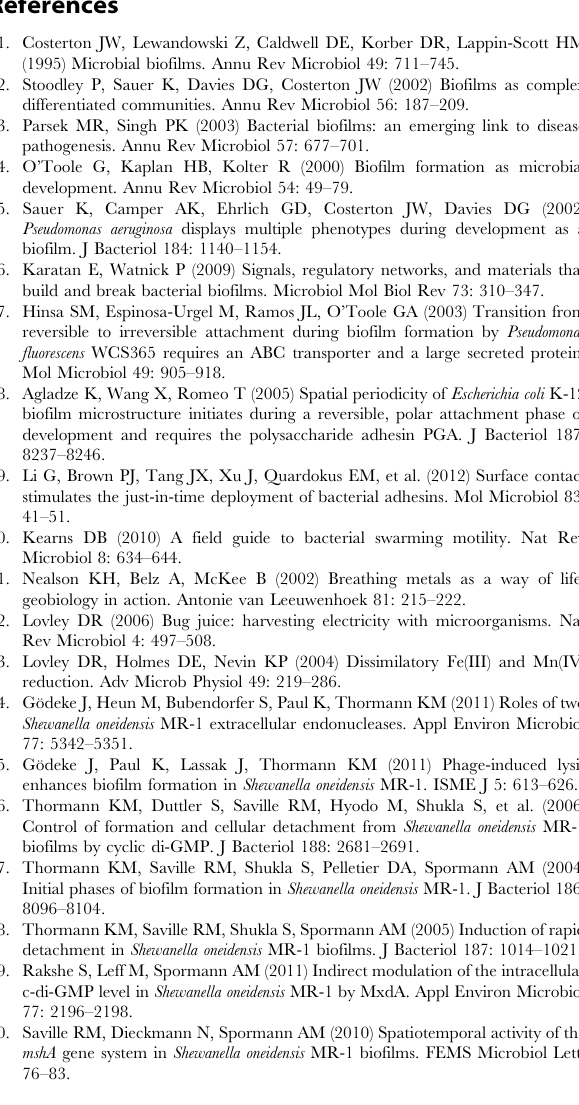
PCR are shown. The coefficient of determination R 2 represents the statistical variance of the transcriptome data. Table S1 Genes significantly upregulated after 60 minutes of attachment compared to 15 minutes of attachment. Table S2 Genes significantly downregulated after 60 minutes of attachment compared to 15 minutes of attachment. Table S3 Differentially regulated genes potentially related to cell lysis and eDNA turnover. Table S4 Differentially regulated genes related to ‘‘metabolic adaptation’’ - Carbohydrate transport and metabolism. Table S5 Differentially regulated genes related to ‘‘metabolic adaptation’’ - Lipid transport and metabolism.